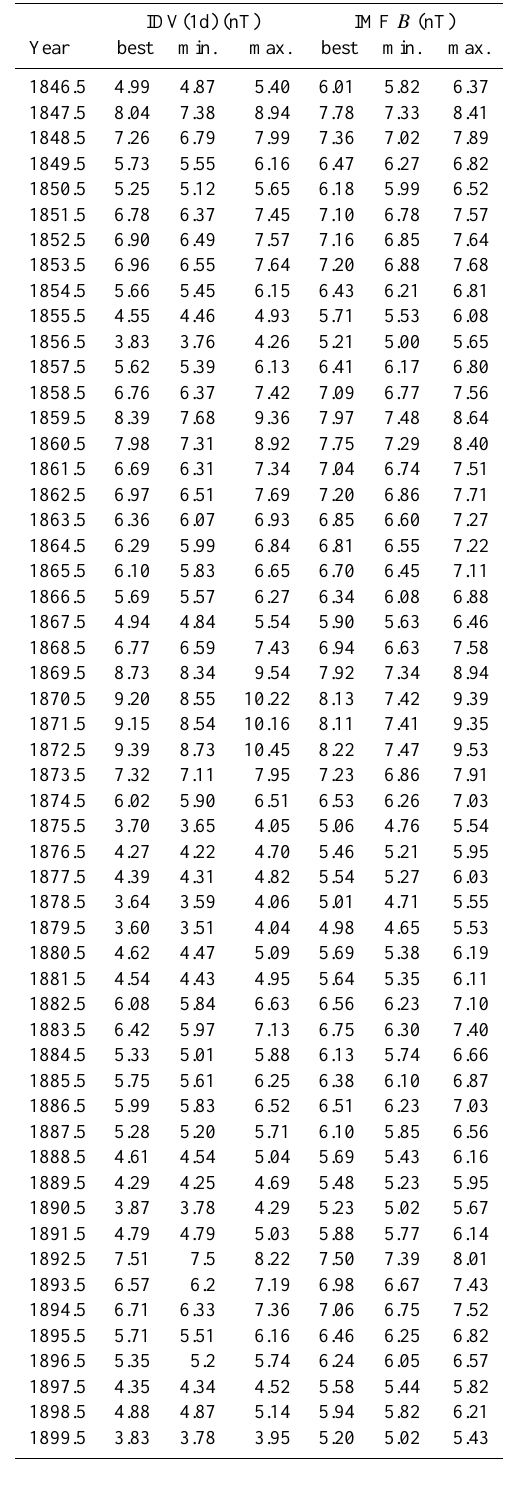
Table 1. The full data series with corrected data for the period 1866–1875. Annual IDV(1d) composite and derived IMF B